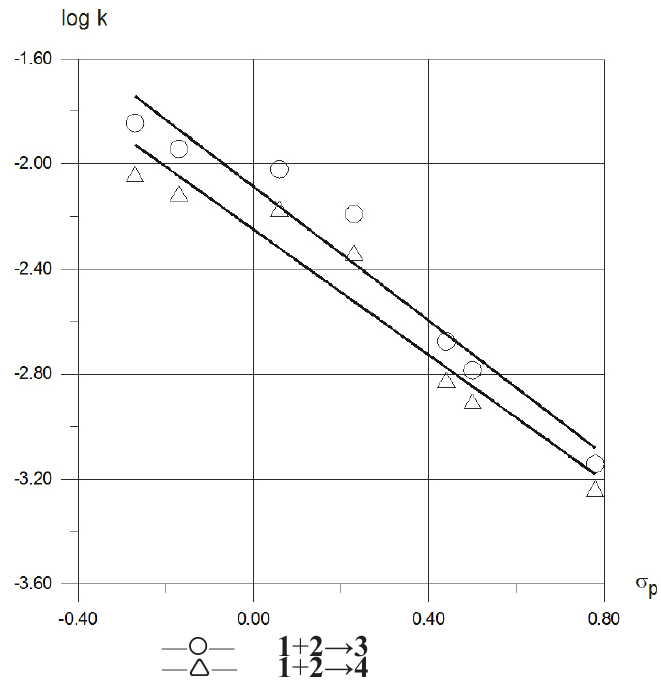
Figure 1. Plot of log k vs Hammett constants σ